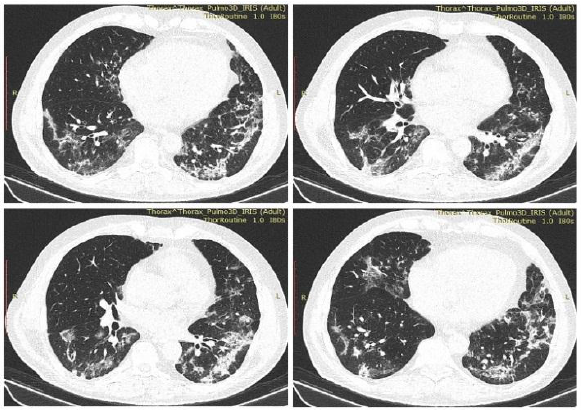
Figure 11 . CT images: signs of gross reticular